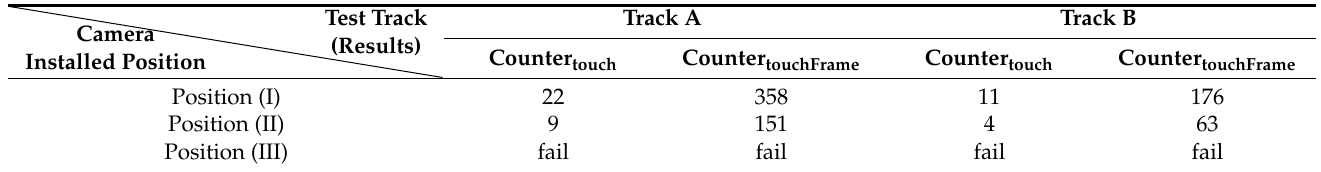
Table 2. Comparison results of test driving for ten laps at three camera installation